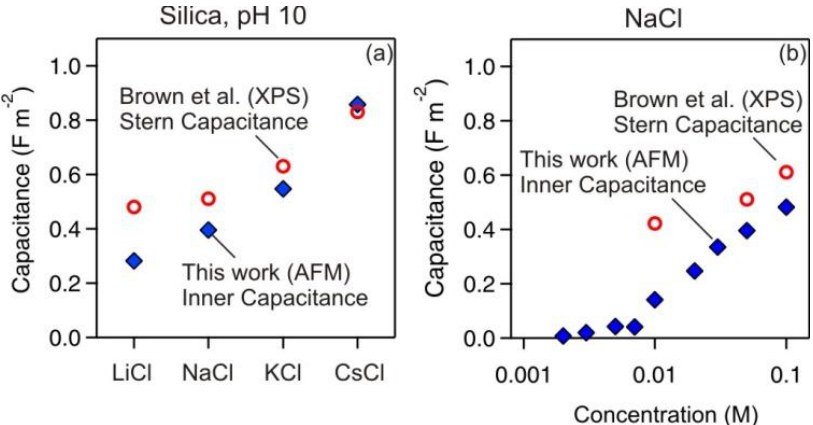
Figure 5. ( a , b ) Comparison to XPS data by Brown et al. [14,19] Capacitance as a function of cation type at 50 mM salt concentration and pH 10, and ( b ) as a function of NaCl concentration at pH 10. Open symbols data by Brown et al., closed symbols this work.